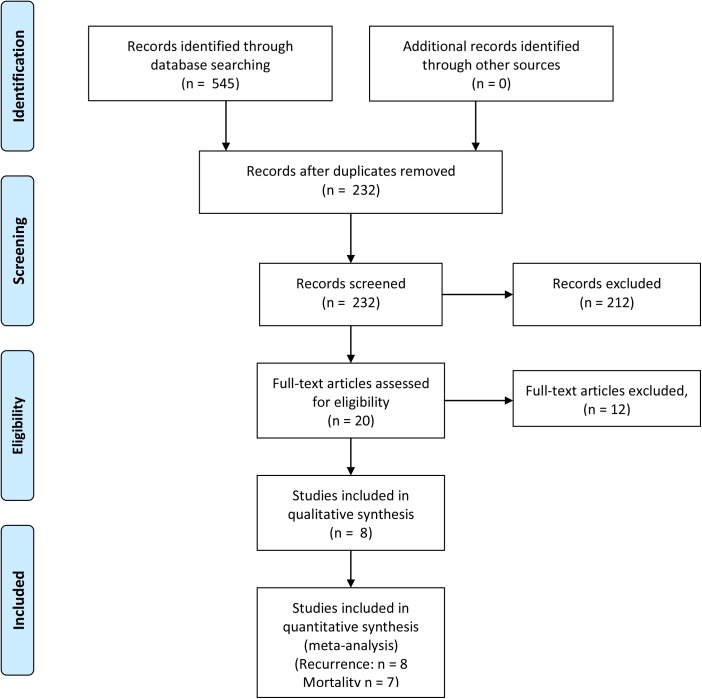
Flow chart of study selection.